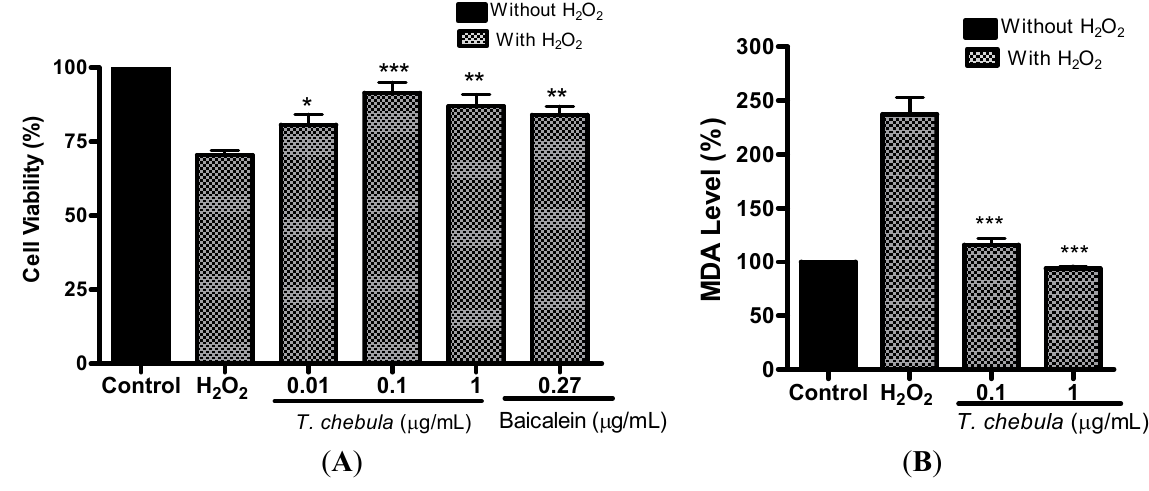
O -induced cell death and lipid 2 2